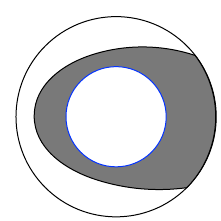
Figure 12 . Another limit of the ring